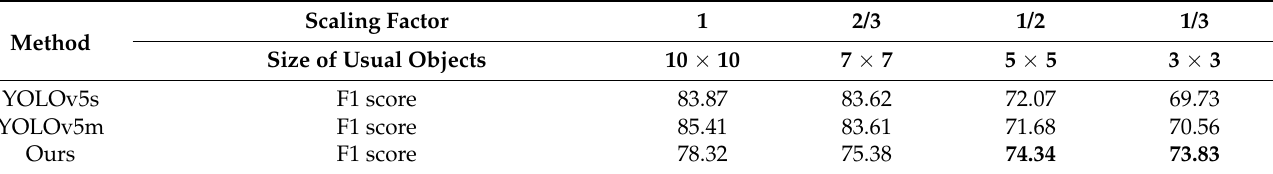
Table 5. Comparison of our method with YOLOv5 on our